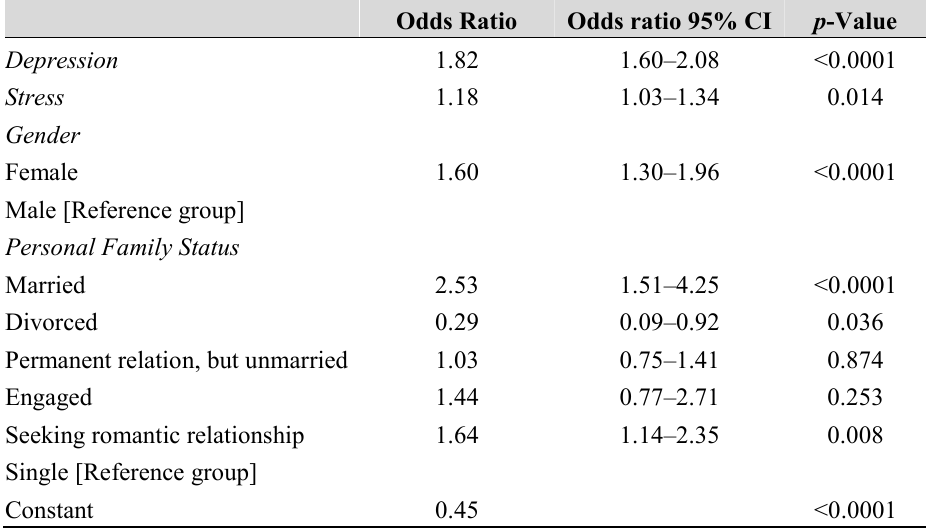
Table 3. Stepwise logistic regression results.